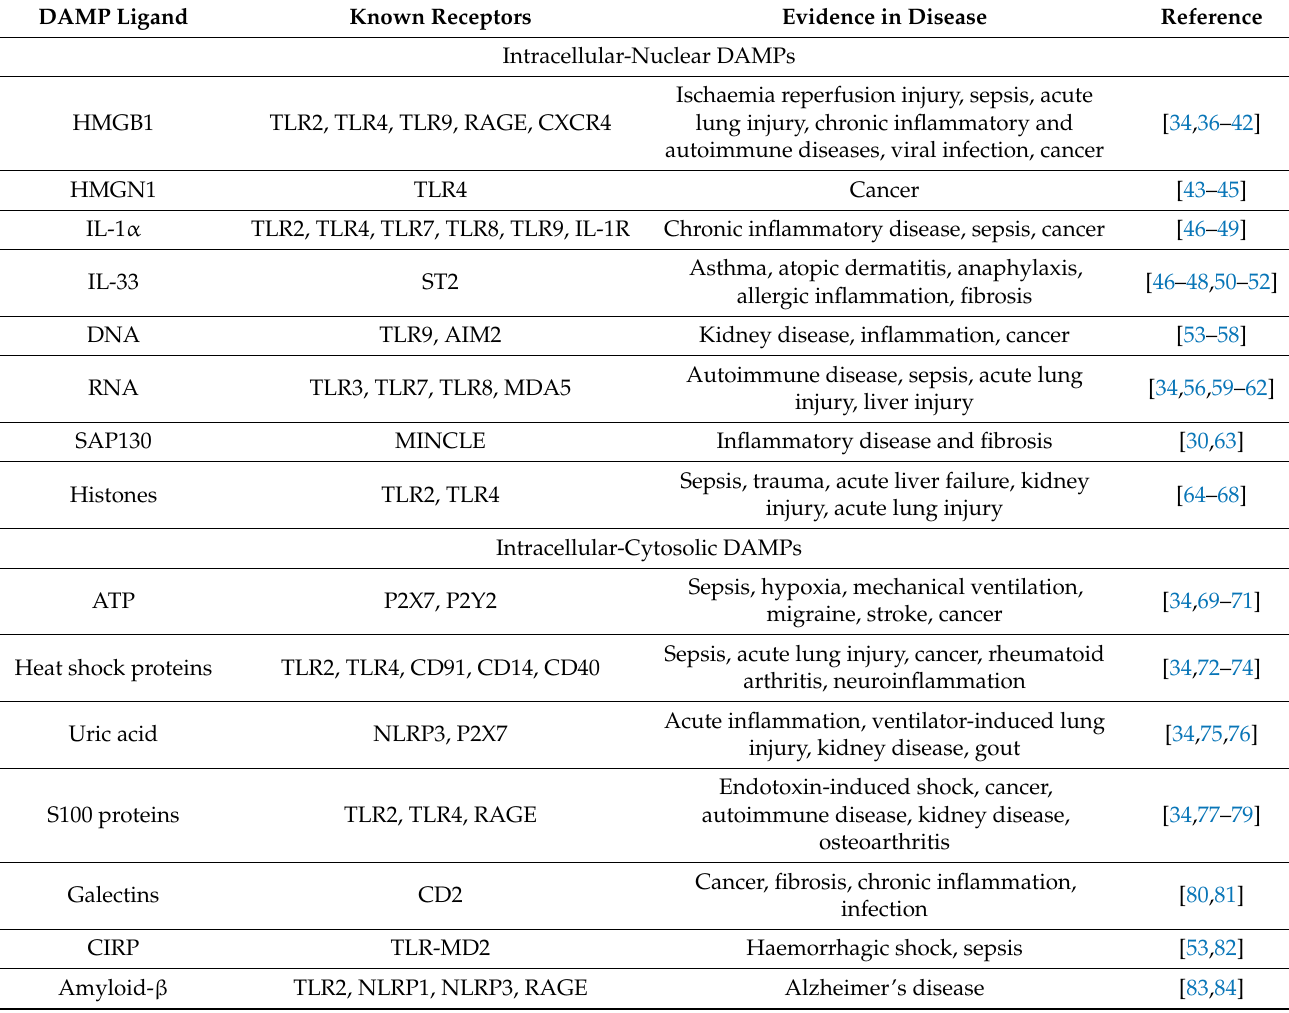
Table 1. Table of well-characterised DAMPs, their receptors, and evidence in disease. DAMP Ligand Known Receptors Evidence in